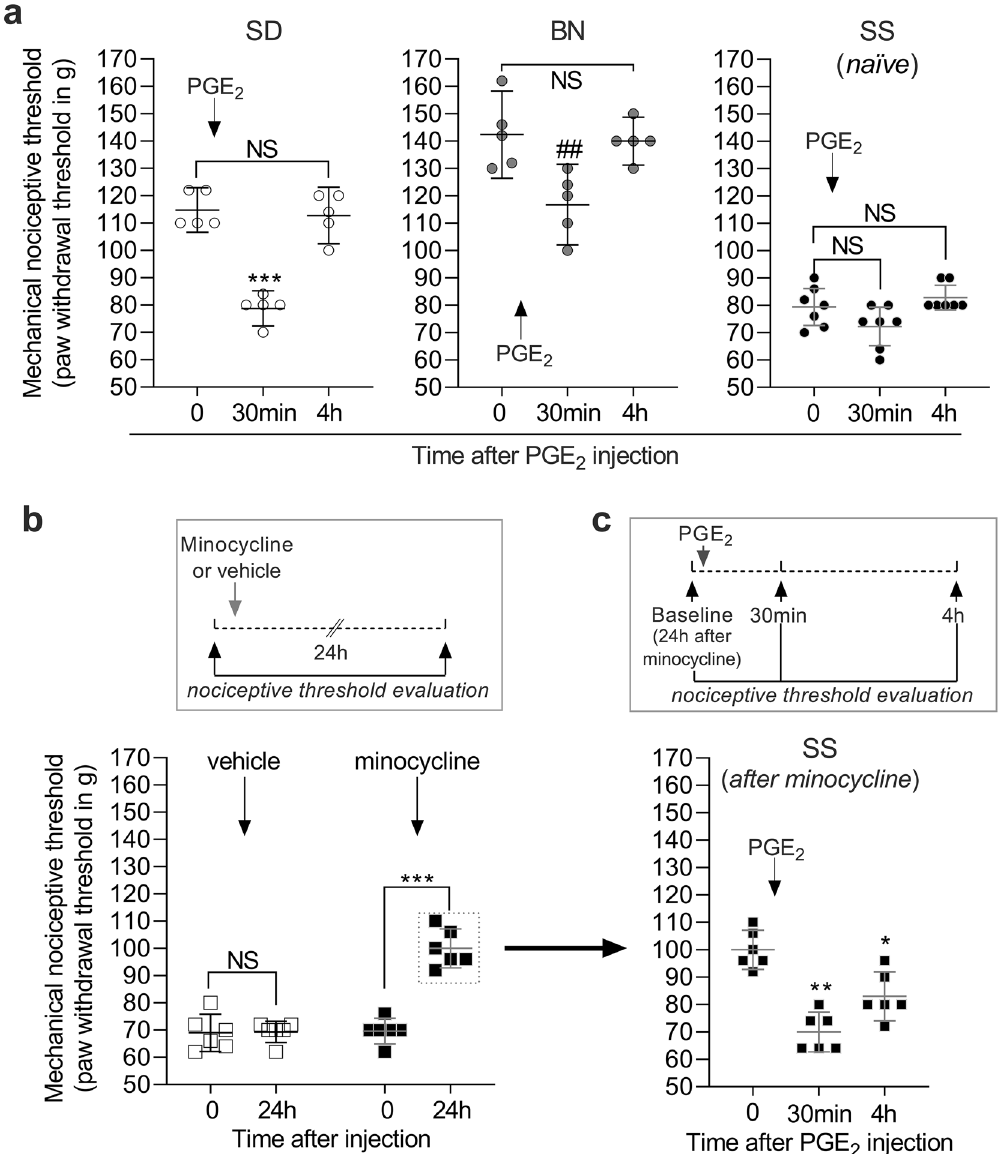
Figure 7. SS rats present increased responsiveness to the proalgesic mediator PGE 2 . ( a ): PGE 2 (100 ng) was injected i.d. on the dorsum of the hindpaw of naïve SD (left), BN (middle) and SS (right) rats. Nociceptive thresholds were evaluated, by the Randall-Selitto test, before, 30 min and 4 h after injection. Significant decrease in threshold (hyperalgesia) was observed 30 min after PGE 2 in both SD and BN rats (F (1.471, 5.885) = 54.34, *** p = 0.0003 for SD; F (1.178, 4.714) = 23.17, ## p = 0.0011 for BN, when compared to baseline, one-way repeated measures ANOVA followed by Bonferroni posttest) and, by the 4th h, the thresholds were not significantly different from the baseline ( p > 0.9999 for both strains, NS). In the naïve SS group, however, the PGE 2 effect was not evident due to the low nociceptive baseline threshold, close to the detection limits of the Randall- Selitto device (F (1.339, 8.032) = 4.179, p = 0.3774 and p = 0.4616, both NS, when the thresholds at 30 min and 4 h are compared to pre-PGE 2 levels, respectively). Thus, to visualize the PGE 2 effect in SS rats, a separate group received minocycline (( b ), full symbols, 30 mg/kg, i.p.). A control group (empty symbols) received vehicle. Evaluation of the nociceptive thresholds on the dorsum of the hindpaw 24 h later showed a significant increase in threshold in the minocycline-treated group (t 5 = 8.113, *** p = 0.0005, when the thresholds before and after minocycline were compared, paired Student’s t-test; for the vehicle-treated group, t 5 = 0.1465, p = 0.8893, NS). In sequence (24 h after minocycline), the minocycline-treated rats received an i.d. injection of PGE 2 (100 ng) on the dorsum of the hindpaw ( c ), and the nociceptive thresholds were evaluated 30 min and 4 h later. A robust decrease in nociceptive threshold (hyperalgesia) was observed 30 min after PGE 2 (F (1.434, 7.171) = 27.75, ** p = 0.0026, when compared to pre-PGE 2 levels) that was still significant at the 4th h (* p = 0.0291), indicating a prolonged nociceptor sensitization. The schematics on the top of ( b and c ) describe the respective protocols used. This finding indicates that nociceptors in SS rats are hyperresponsive to proalgesic agents such as PGE 2 . Panel ( a ), SD, n = 5; BN, n = 5; naïve SS, n = 7; Panel ( b ) n= 6 for both groups; Panel ( c ), n =